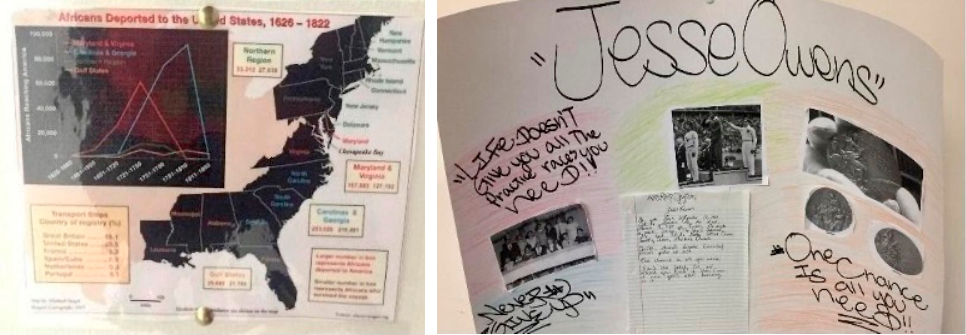
Figure 1. Students’ cultural history